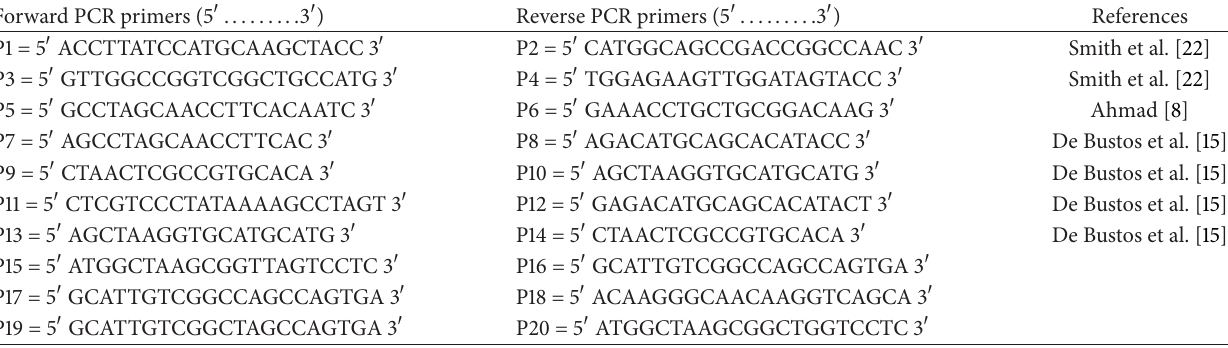
Table 1: STS primers used to amplify HMW glutenin subunits.